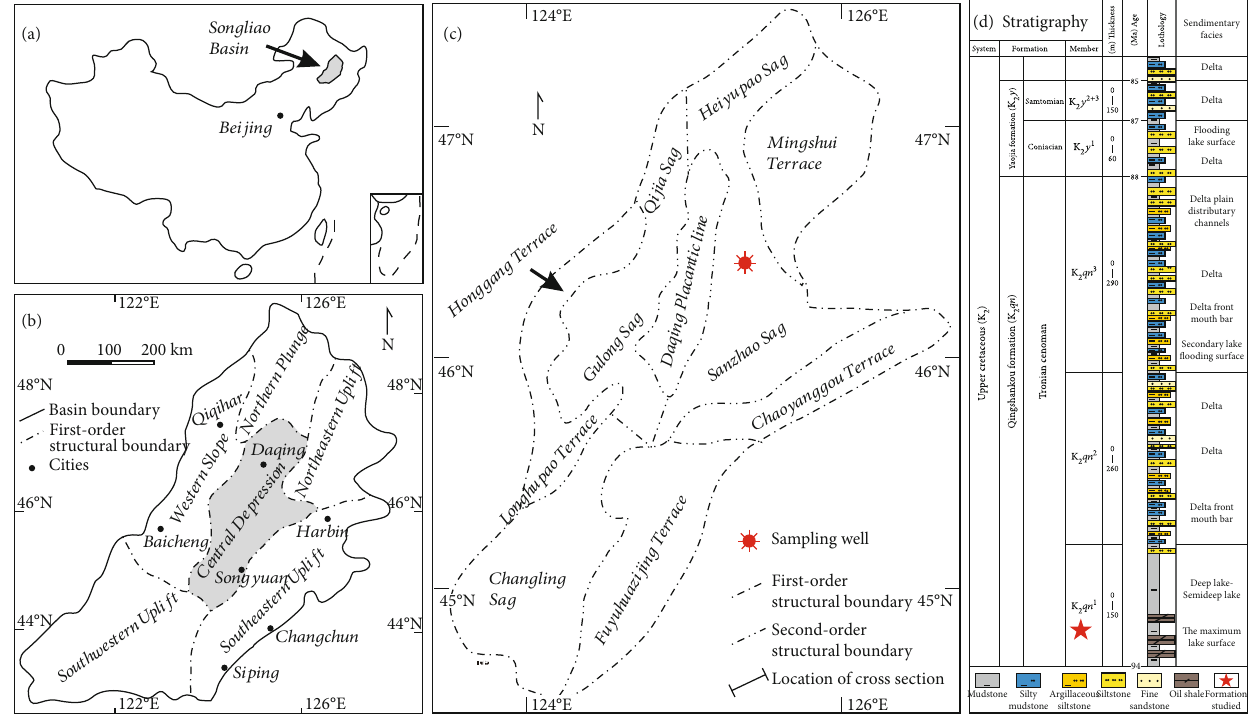
Figure 1: (a) The location of Songliao Basin, (b) tectonic unit division, (c) studied area, and (d) stratum histogram of Songliao Basin. Table 1: Bulk geochemical parameter results of shale samples from the K